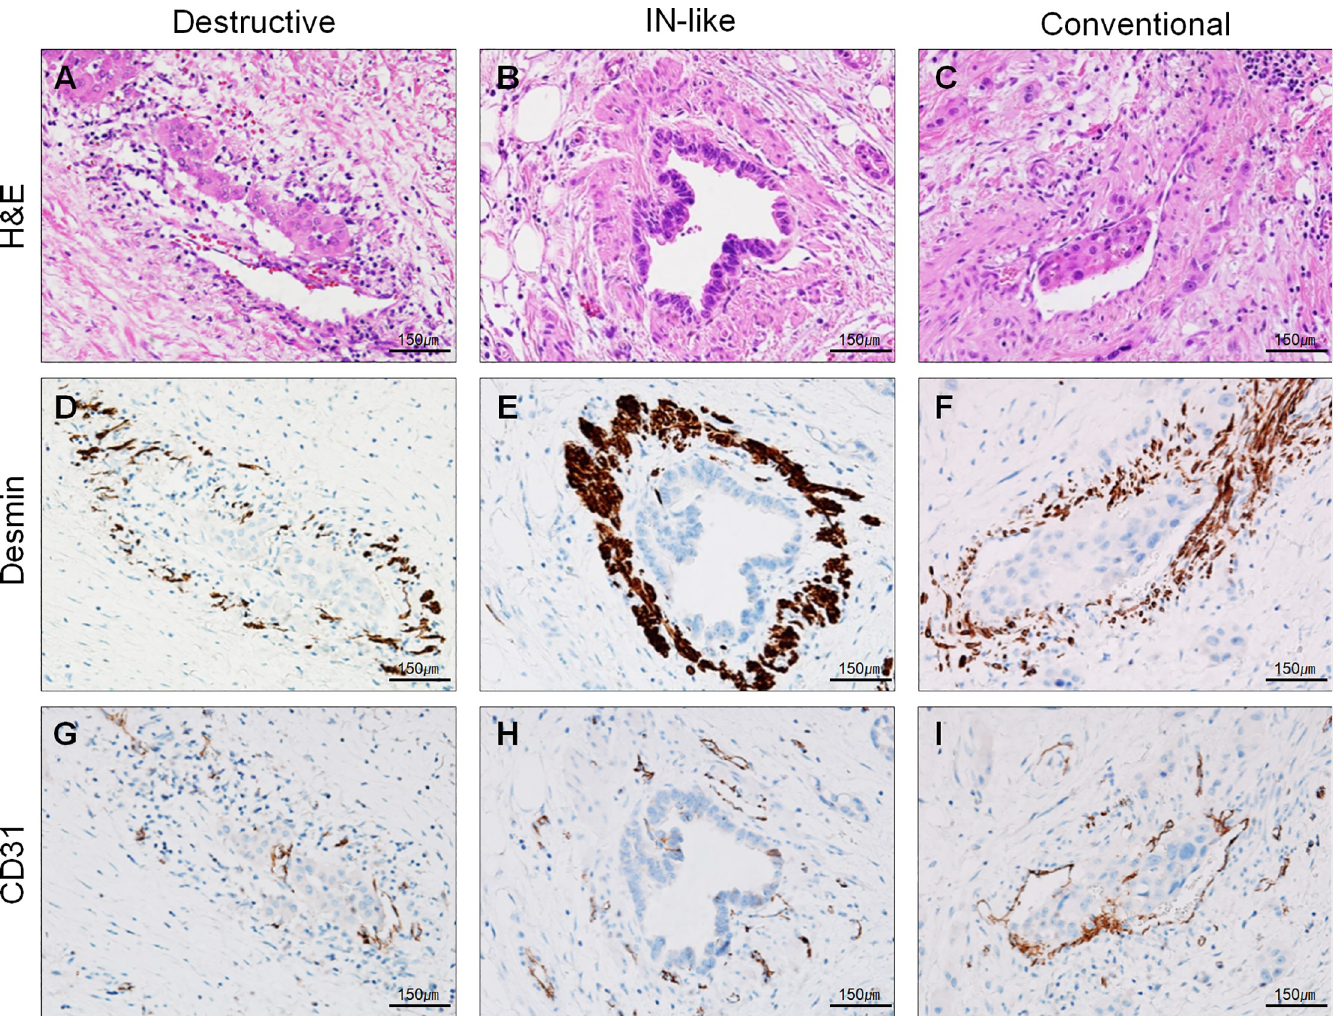
Fig 2. Representative H&E staining and single desmin or CD31 immunolabeling images of different patterns of venous invasion of pancreatobiliary tract cancers. Left column (A, D, and G) , suspicious destructive pattern. Smooth muscle layer is not identified on H&E but observed on desmin immunolabeling; central column; (B, E, and H), intraepithelial (IN)-like pattern, cancer cells within venous space mimic dysplastic cells of intraepithelial neoplasia showing well-circumscribe outer desmin- positive smooth muscle layer (E) and no CD31 expression (H) ; right column (C, F, and I) , conventional pattern, well-circumscribe outer desmin-positive smooth muscle layer and cancer cells within venous space (F) , cancer cells within venous space attached to endothelial cells showing partial loss of CD31 expression (I) , while cancer cell-non-attached endothelial cells show brown color ( A-C , H&E staining; D-F , desmin immunolabeling; G-I , CD31 immunolabeling; all × 200 magnification).